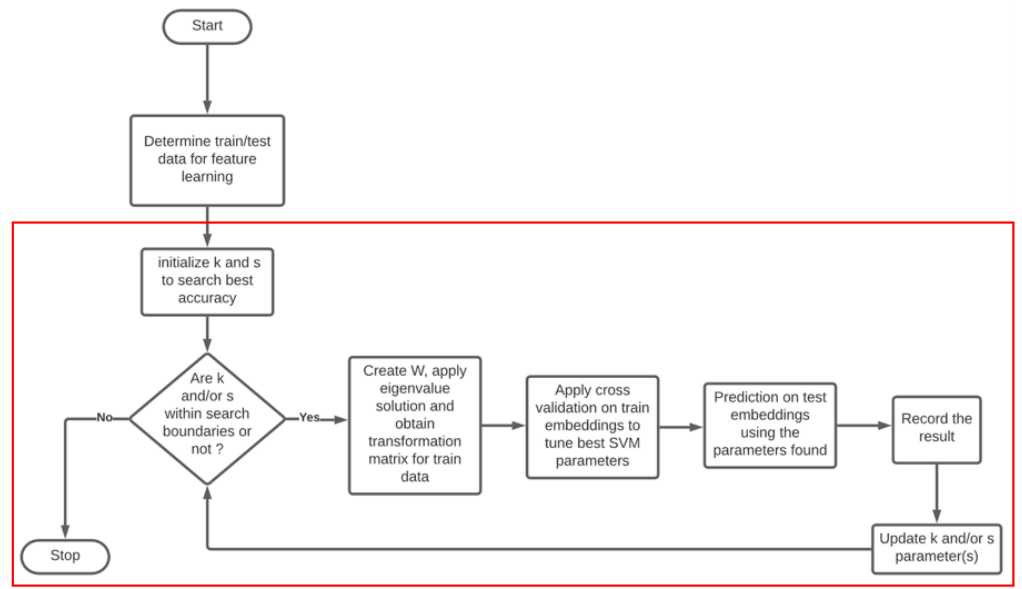
Figure 1. The flowchart used for classification. (Red rectangle contains the process on a selected training/test dataset for feature learning. This part is repeated five times with randomly selected training/test datasets and classification results are kept, and then averaged to find optimal k and s . Cross validation is applied to train embeddings to determine hyperparameters. Then, the test data is evaluated. The test data are completely unseen data and used just for prediction).